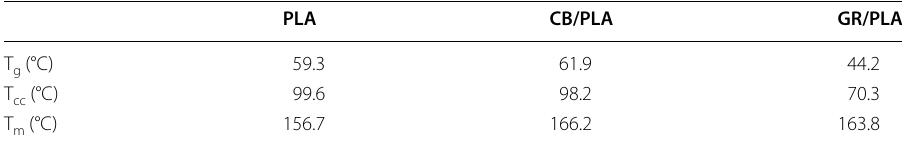
Table 3 Thermal properties of PLA, carbon black/PLA, and graphene/PLA filament for 3D